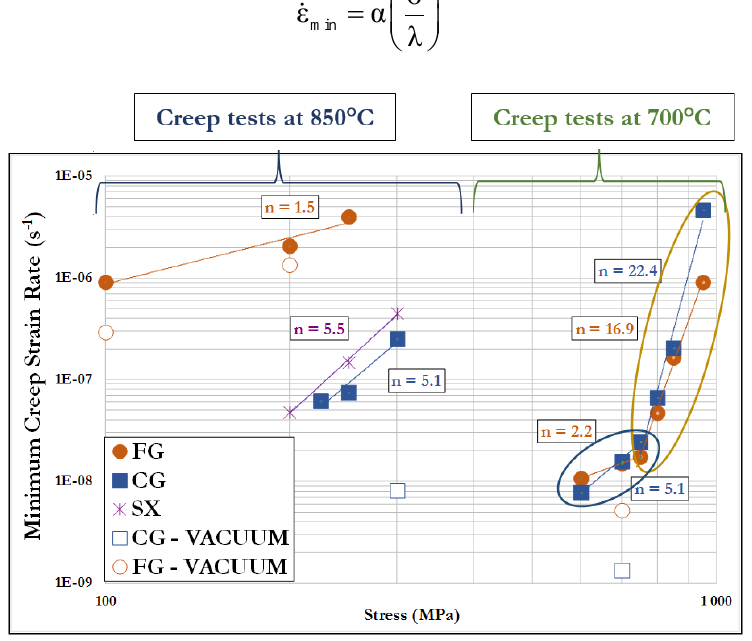
Figure 7. Minimum creep strain rate as a function of the applied stress; n = Norton’s